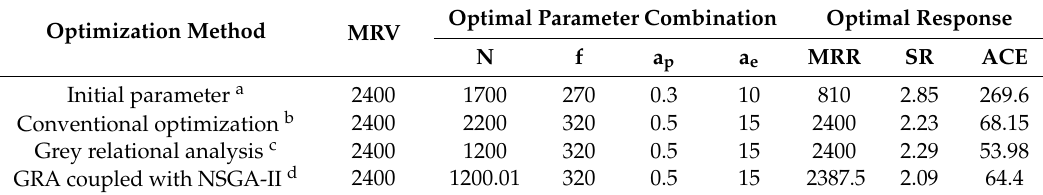
Table 6. Optimal responses using various optimization